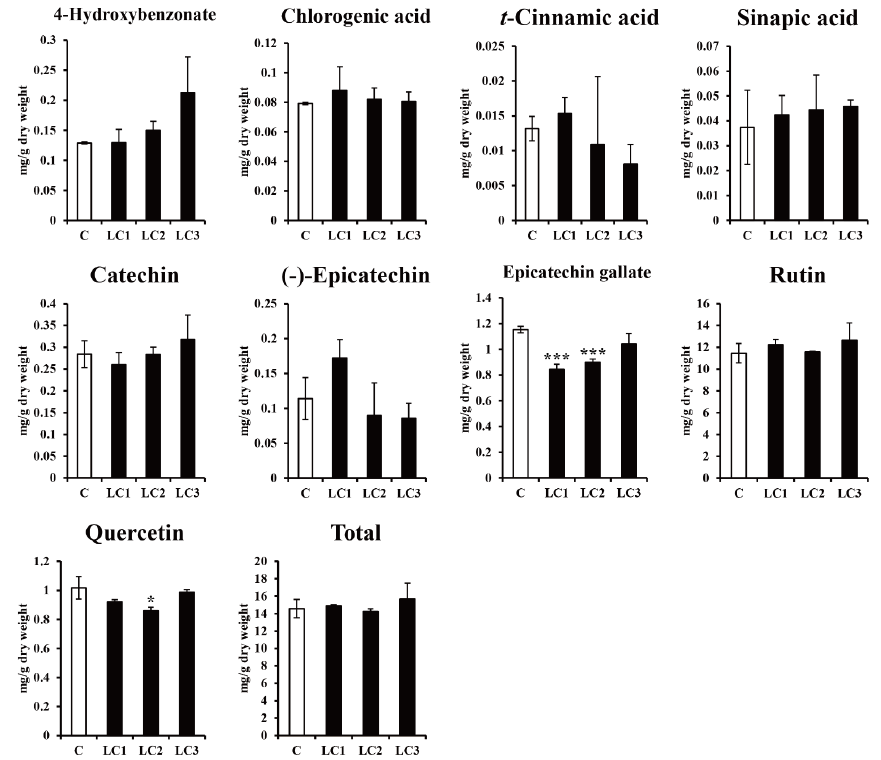
Figure 4. Effect of dark treatment on the phenolic compound accumulation of hairy root cultures in Fagopyrum tataricum . C: GUS -overexpressing hairy root line 1; LCn: ZmLC -overexpressing hairy root lines. Asterisks represent statistical significance (* p < 0.05; *** p < 0.001).